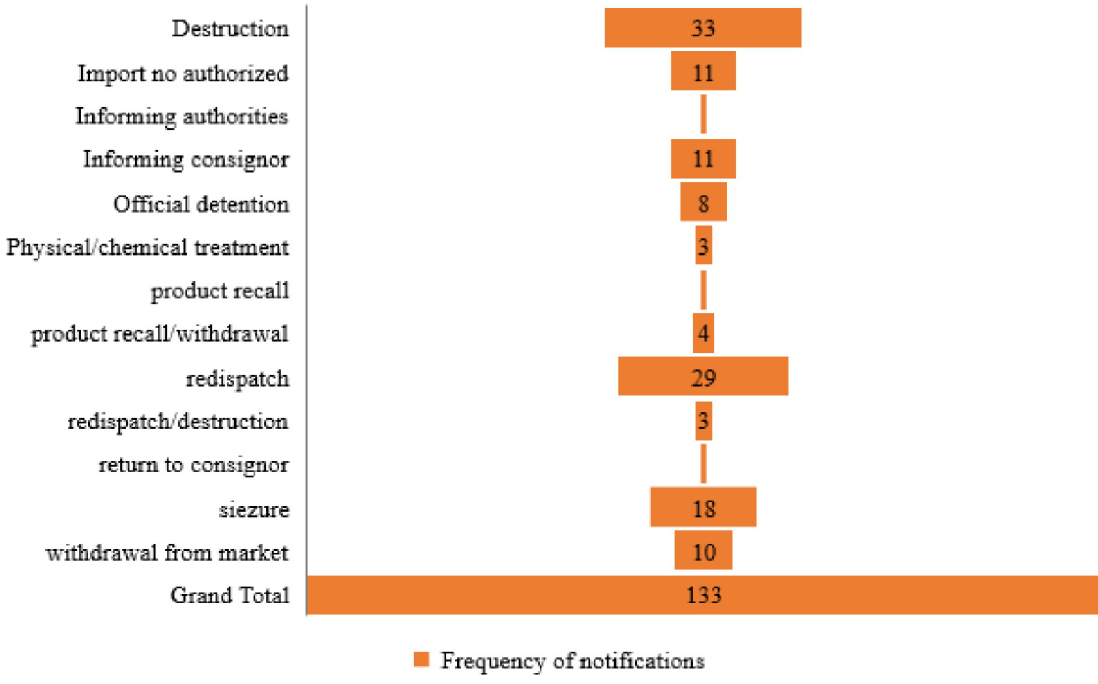
Fig 7. Frequency of actions taken on food/feed exports from ASEAN